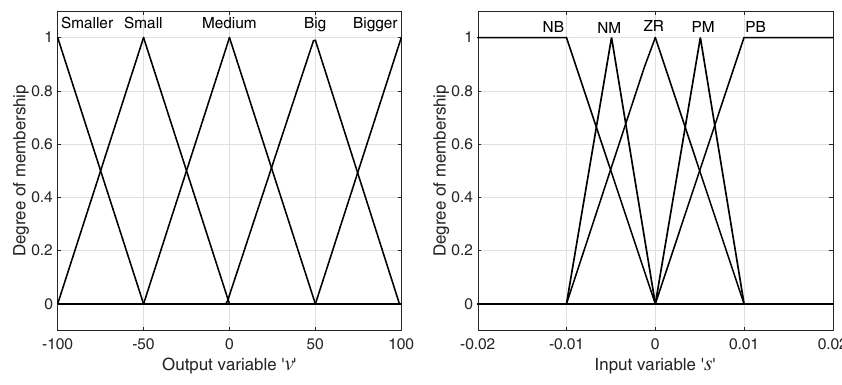
Figure 10. Membership functions of the